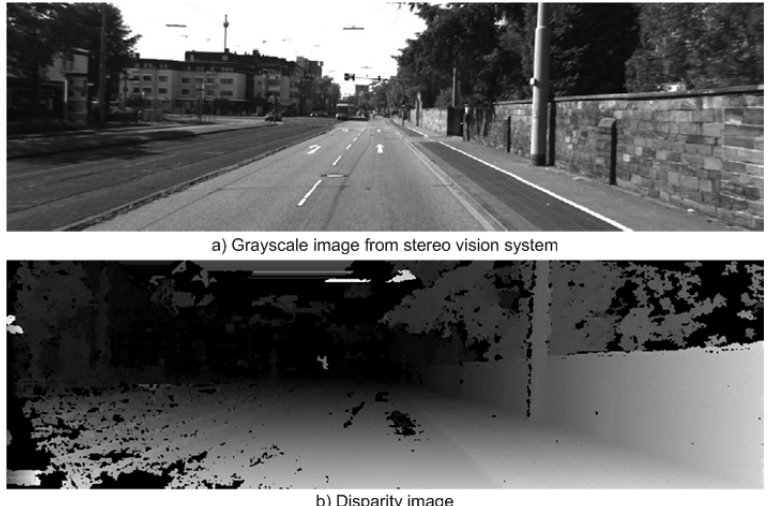
Figure 6. Curb detection using stereo vision system [36].